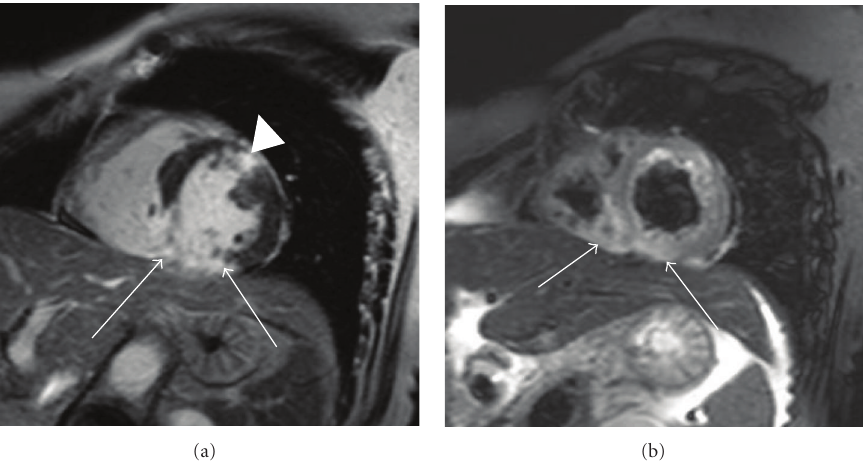
Figure 2: 63-year-old female with myocardial infarction. Short-axis delayed-enhancement MRI (a) shows myocardial infarction at the inferior myocardium (arrows) and the anterior myocardium (arrowhead). Short-axis T2-weighted cardiac MRI (b) shows only myocardial edema associated with acute myocardial infarction in the inferior myocardium and right ventricular myocardium (arrows) that are consistent with blood supply from the right coronary artery.